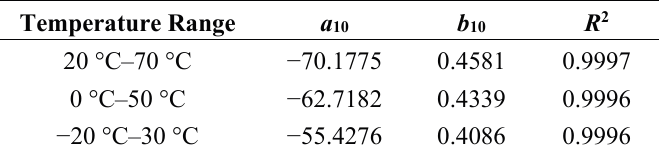
Table 1. Determination of coefficients a 10 and b 10 for the Landsat 8 TIRS Band